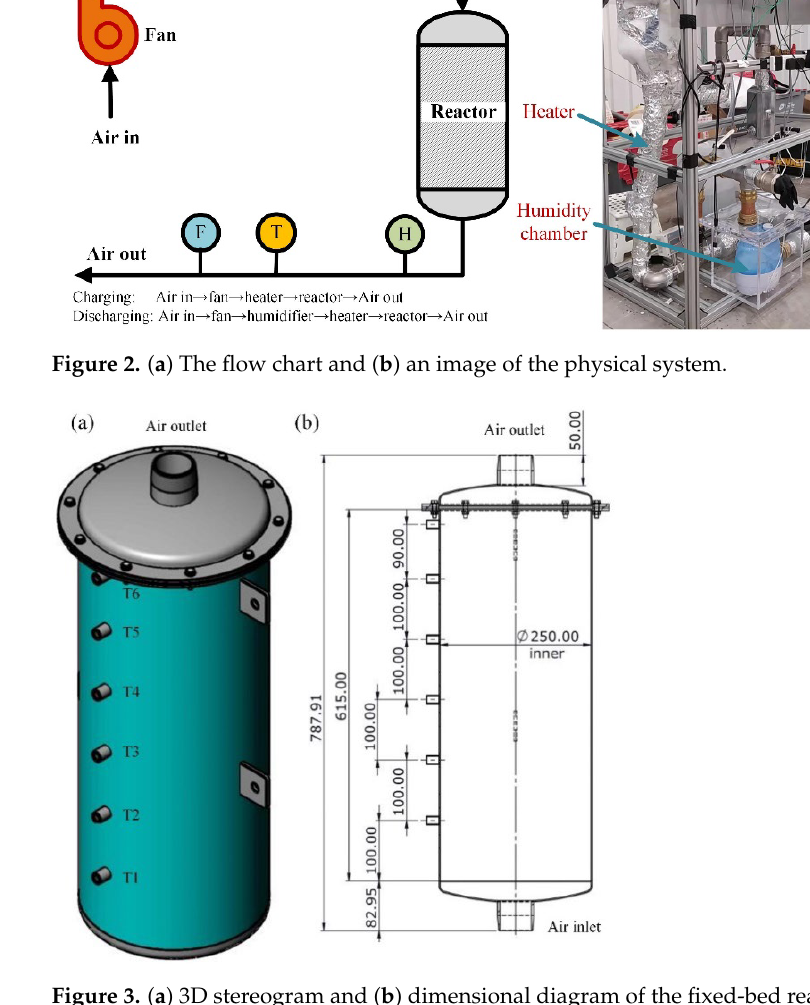
Figure 2. ( a ) The flow chart and ( b ) an image of the physical system.